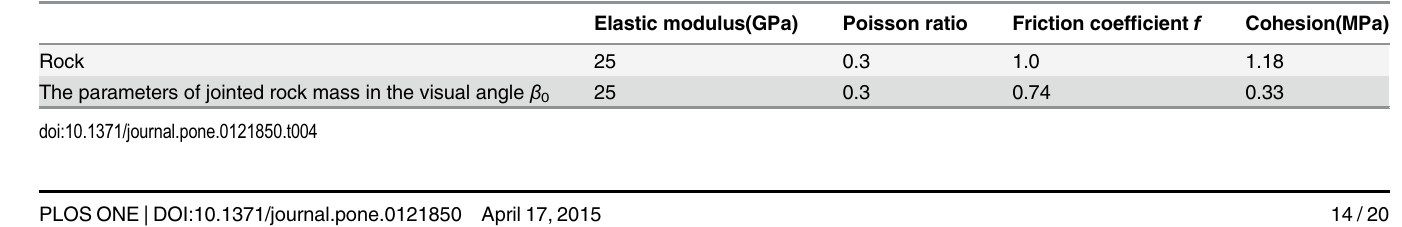
Table 4. The parameters of the rectangle beam